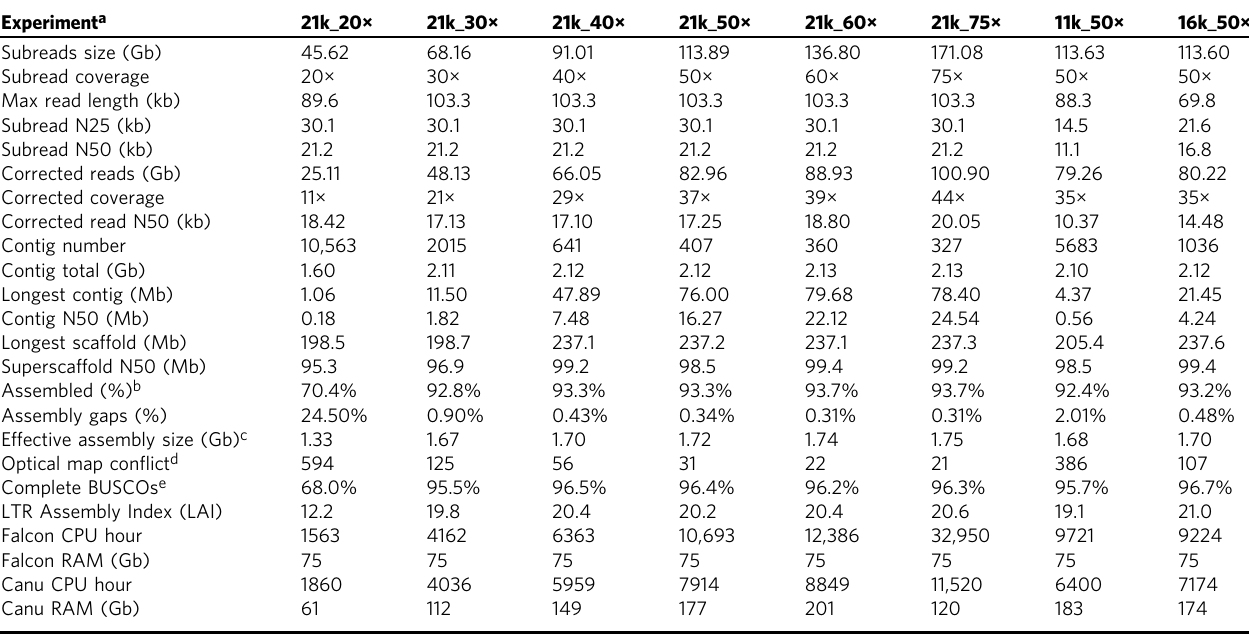
Table 1 Summary statistics for NC358 assemblies. Experiment